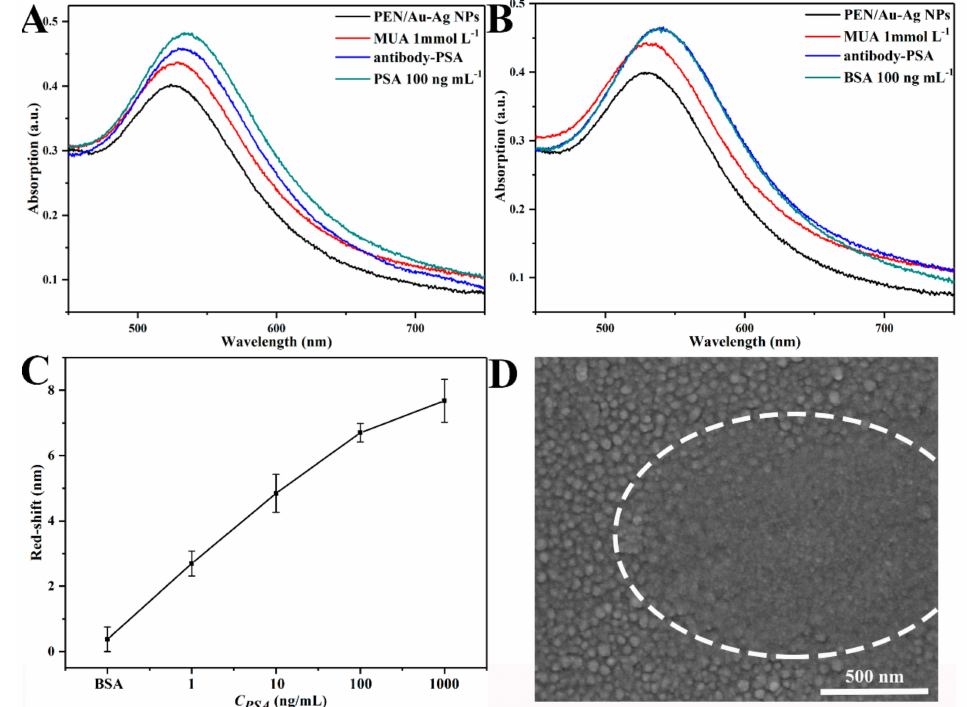
Figure 4. The LSPR spectra evolution of PEN / Au-Ag NPs upon specific immunodetection of prostate-specific antigen (PSA) ( A ). Negative control experiment results from using non-specific bovine serum albumin (BSA) ( B ). Dose dependent responses curve to di ff erent concentrations of PSA ( C ), and SEM images of PEN / Au-Ag NPs after specific binding of 100 ng / mL PSA ( D